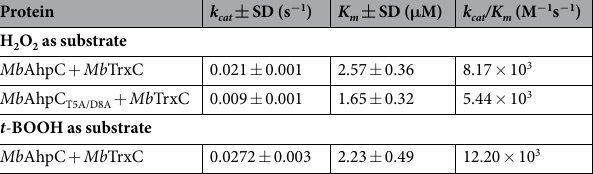
debate 1, 15 and its interaction epitopes are not resolved yet. It may reflect the difference of mycobacterial AhpCs to related typical 2-Cys peroxiredoxins by employing three rather than two cysteine residues involved in catalysis 13 . Interestingly, the dimer structure of Mt AhpC C176S mutant 13 (Fig. 1B) as well as a protein sequence analy- sis of mycobacterial AhpCs revealed differences in the amino acid composition of AhpCs from other sources (Fig. 1C), in particular the presence of a unique stretch of 15 amino acid residues and the secondary structure of its N-terminal 40 residues. This N-terminal stretch, highlighted in green in Fig. 1B, is proposed to span one AhpC molecule and thereby bridging the two oligomeric interfaces, in which the catalytic C P and C R of the AhpC-ring are located. In addition, a crystal structure alignment with Ec AhpC revealed that Mt AhpC C176S forms an addi- tional loop in the N-terminus from residues 23–34 (Fig. 1B, magenta ). Elucidating the molecular mechanism and architecture of mycobacterial AhpC as well as its interaction with AhpD and TrxC in solution will shed light on the potential differences in function and regulation of the unique mycobacterial thioredoxin- and peroxiredoxin system. Here we used 2-dimensional (2D) projection analysis of electron micrographs to visualize the dodecamer ring of reduced wild-type (wt) AhpC from M . bovis (BCG strain; Mb AhpC), whose amino acid sequence is identical to Mtb , and to demonstrate the oligomeric formation of Mb AhpC due to redox-modulation. Using NMR-titration experiments of labeled Mb TrxC with Mb AhpC, the epitope to which Mb AhpC binds in Mb TrxC is presented and opens the door for an ideal drug target. Truncations and amino acid substitutions of residues in of the unique N-terminus of Mb AhpC provide insights into their structural and enzymatic roles.